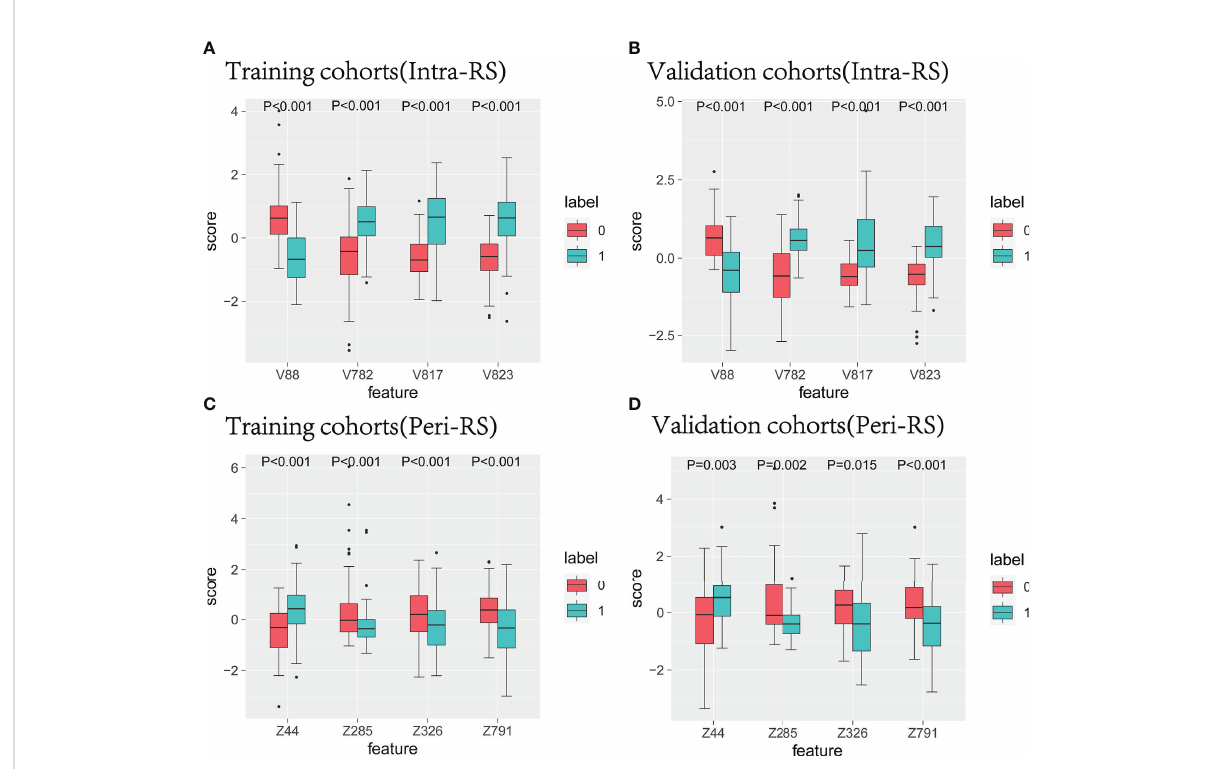
FIGURE 4 The characteristic box line map in the training set and veri fi cation nodule (A, B) and around the nodule (C, D) . 0 represents benign nodules, 1 represents lung cancer, V represents radiological features in nodules, and Z represents radiological features around nodules.